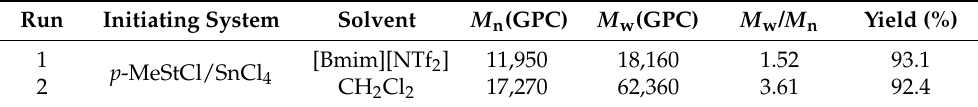
Table 2. p -MeSt cationic polymerization using p -MeStCl/SnCl 4 initiating system in IL and CH 2 Cl 2